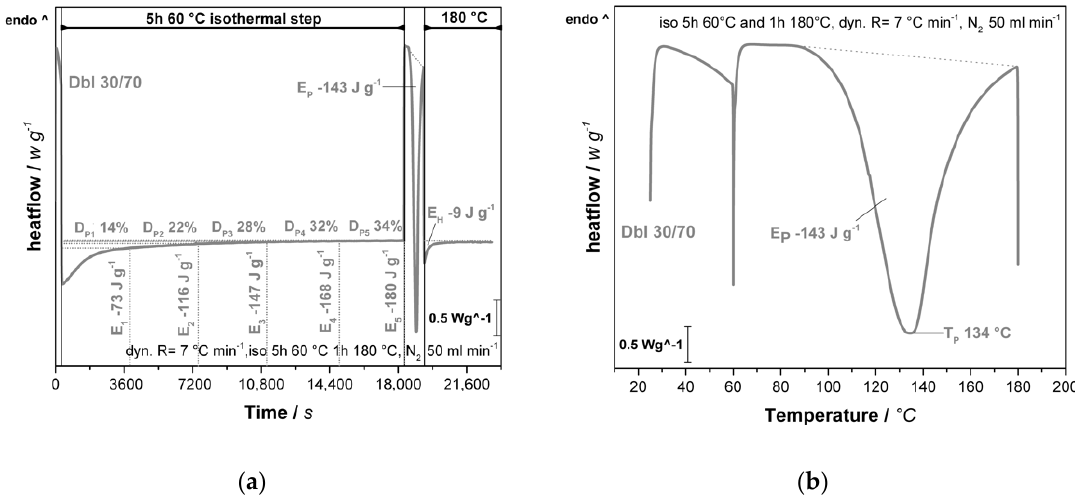
Figure 6. DSC investigations of the DbI 30/70 w system pre-cured for 5 h at 60 °C with process-related heating rates showing ( a ) time-dependent heat flow with indicated energy (E x ) released at specific pre-curing times with corresponding calculated pre-curing degree (D PX ) in a 5 h pre-curing experiment. E p corresponds to the energy released at the peak of the dynamic step and E H to the energy released at 180 °C ( b ) Temperature-related heat flow with indicated E P and reaction peak temperature (T P ).